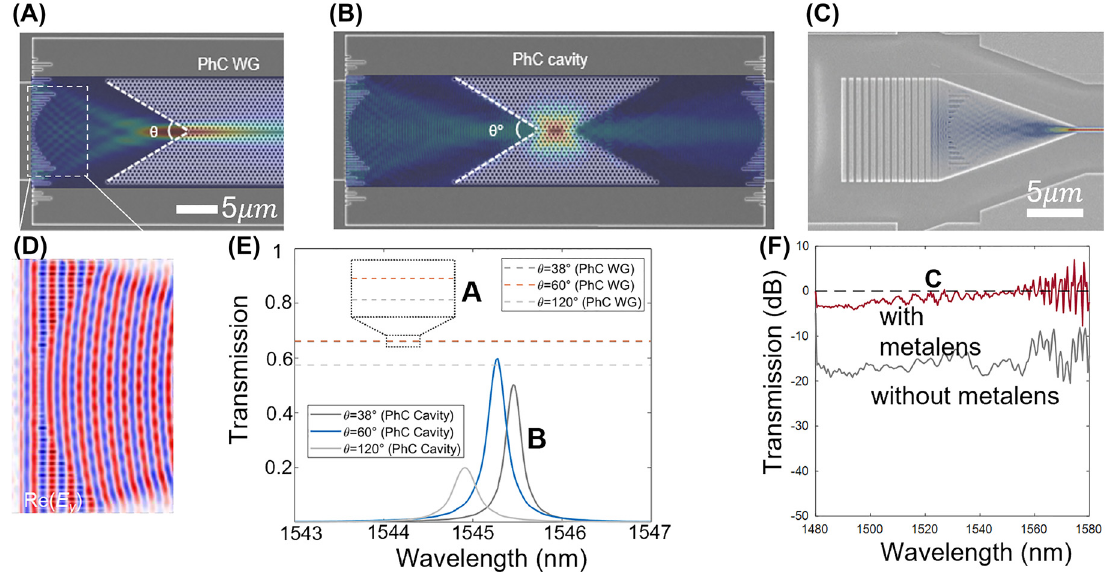
Figure 2: Broadband and low loss mode size conversion with gradient transverse metasurface. (A) Device geometry of metalens – PhC WG system with light distribution of | Ey | 2 on the focal plane. (B) Device geometry of metalens – PhC L3 cavity – metalens system with mode profile at resonance. (C) The SEM image of the metalens enabled ultracompact low loss taper. (D) Zoom-in view of the simulated electrical field distribution of the HCTA based metalens in A–C. (E) Average transmission spectra of the metalens – PhC WG system in (A) and peak transmission of metalens – PhC single modecavity – metalens system in (B), with the PhC coupler angle of 38 ◦ , 60 ◦ , and 120 ◦ [33]. (F) Measured transmission spectra of the device in C (red), compared to the same taper design without metalens (gray) [6]. The figures are reproduced with permission. (A), (B) and (E) ref. [33] © 2021, The Author(s). (C), (D) and (F) ref. [6] © 2019, The Author(s).